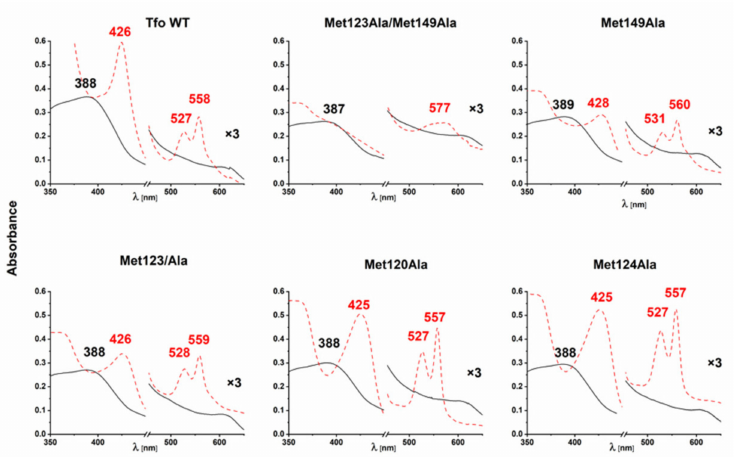
Figure 6. UV-visible absorption analysis of T. forsythia Tfo site-directed mutagenesis variants com- plexed with heme. Spectra were recorded for the protein-Fe(III)heme complexes (solid, black line) and protein-Fe(II)heme complexes (dashed, red line). All spectra were recorded at a 1:1 protein:heme molar ratio for singly or dually replaced methionine residues by alanine residues. WT, wild-type